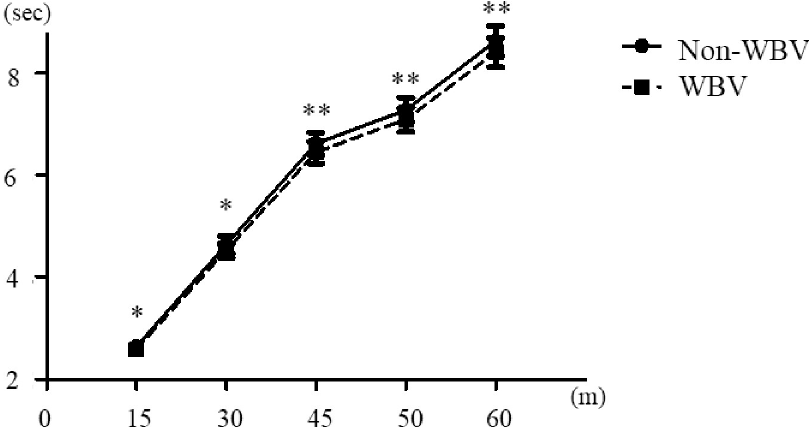
Fig 2. Sprint cumulative record of females. Data in the graph represent the means ± standard deviation. � Analyzed by paired t-test, � p < 0.05, �� p < 0.01.